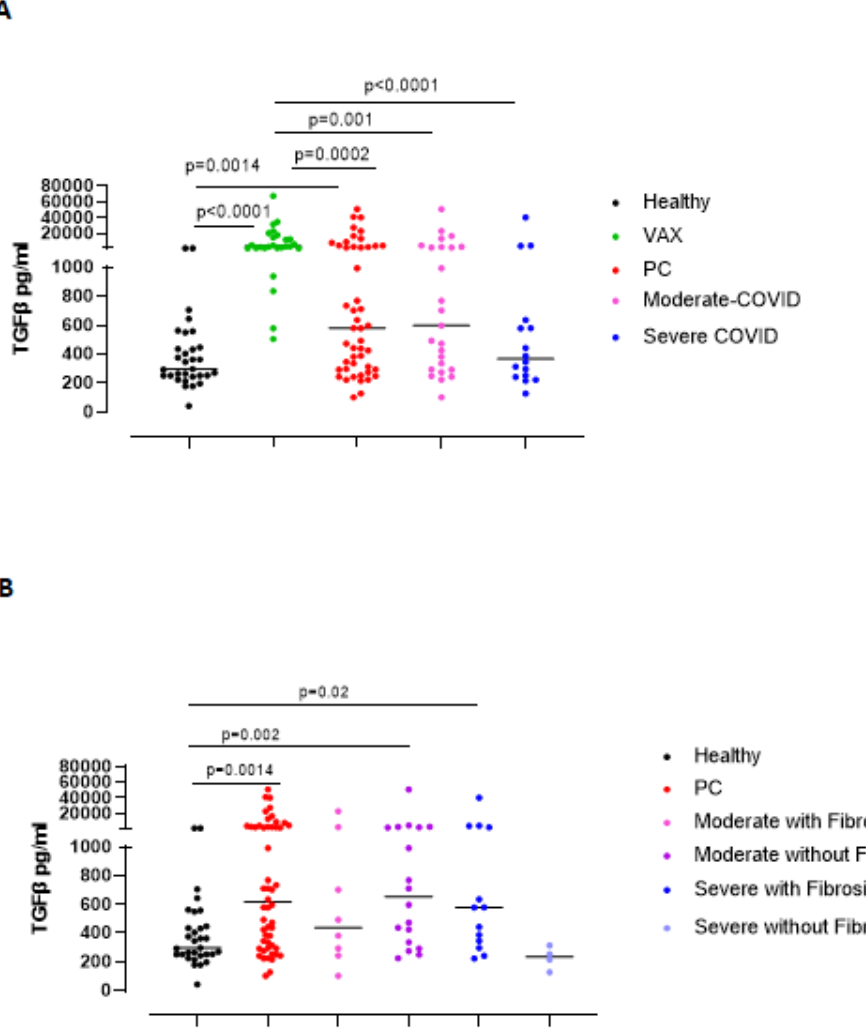
Figure 6. Circulating TGF- β levels were higher in severe post-COVID-19 patients with lung fibrosis events. ( A ) Plasma levels of TGF- β were measured in healthy, vaccinated (VAX) subjects (black and green dots, respectively), and post-COVID-19 (PC) patients (red dots), according to the grade of the pathology (moderate vs. severe, pink and blue dots, respectively). ( B ) TGF- β levels were evaluated according to the establishment of lung fibrosis symptoms (moderate or severe PC patients with or without fibrosis, pink or blue dots and purple and bright blue dots, respectively). Data are expressed as median. Statistical analysis was performed according to the Mann–Whitney U test.